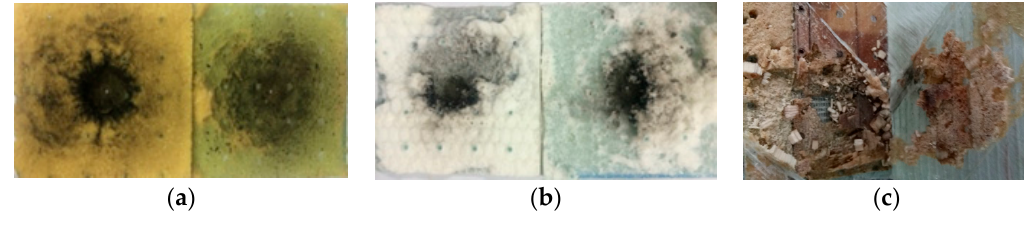
Figure 5. Inside damage of samples: ( a ) PVC; ( b ) PET; ( c ) balsa wood. Table 2. Damage radius (cm).